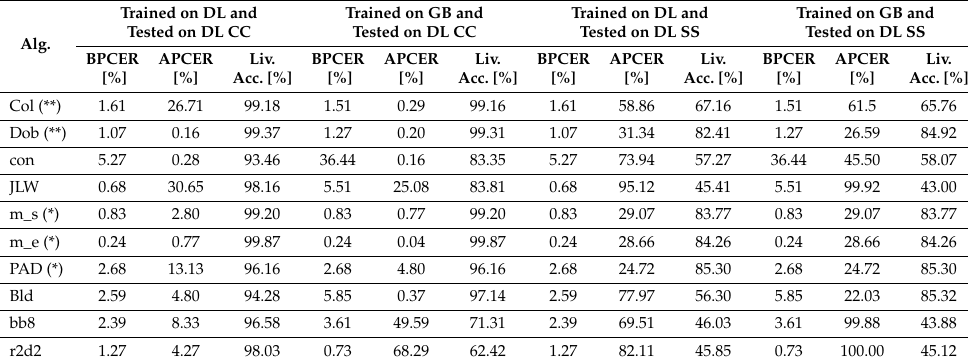
Table 6. Results of LivDet 2021 competitors on test sets acquired with the Dermalog sensor. In particular, Derm CC is a test set acquired with the consensual technique, while Derm SS is a test set acquired with the ScreenSpoof technique. (*) indicates training on both GreenBit and Dermalog Livdet training sets. (**) indicates training on additional data with respect to LivDet training sets.